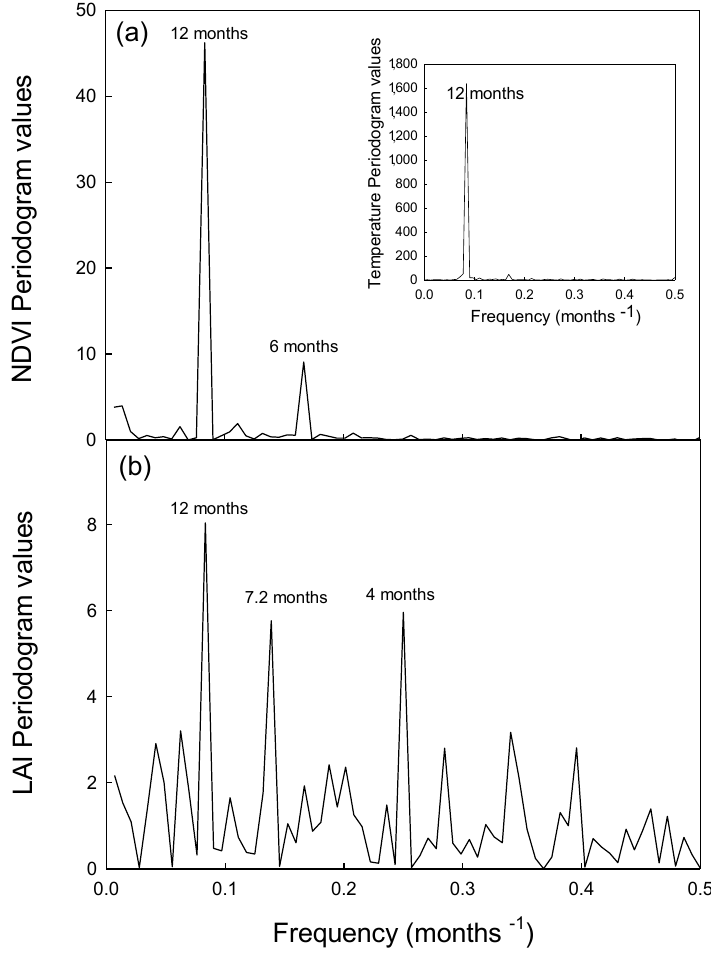
Figure 4. ( a ) NDVI (Normalized Difference Vegetation Index) and ( b ) LAI (Leaf Area Index) peridograms for the native forests. The Y-axes are the percent of variance explained at each frequency, the inverse of the time periods in months. In the inset, the periodogram of average monthly temperatures for a 12-year period is